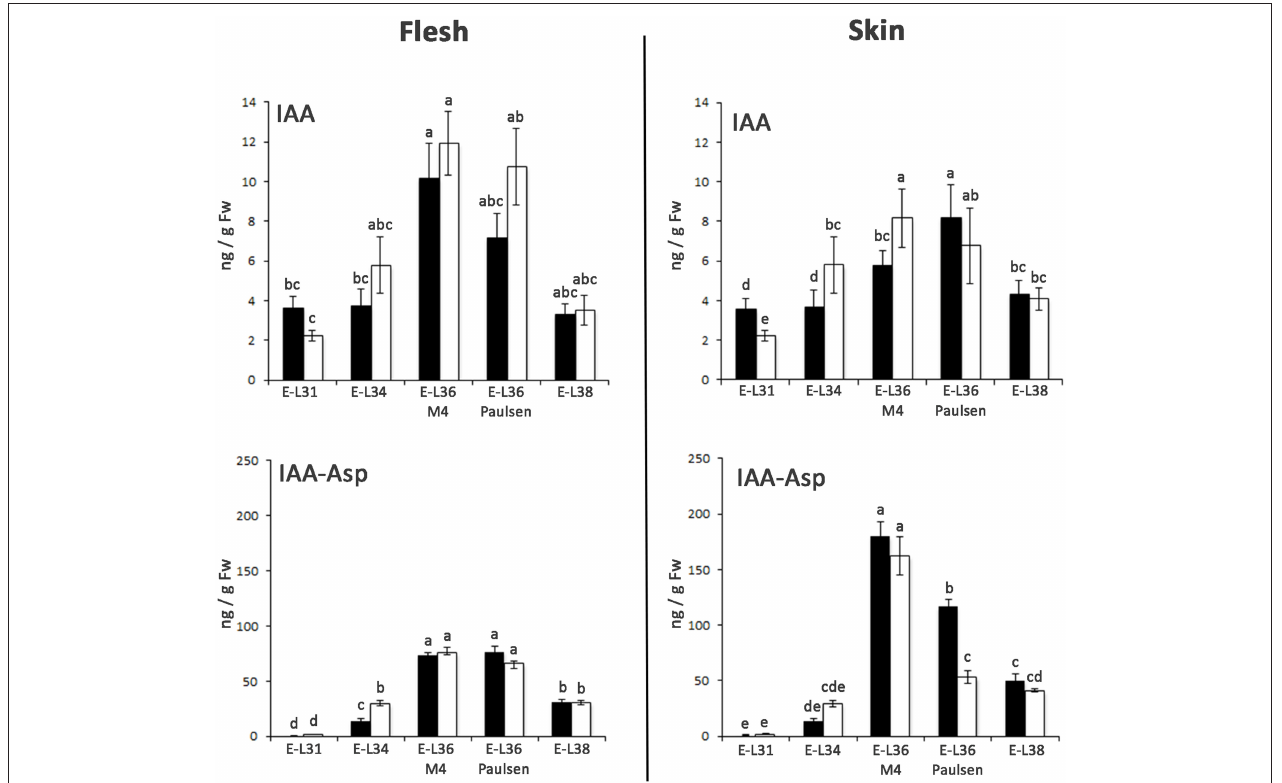
FIGURE 5 | Changes in levels of free IAA and IAA-Asp in flesh and skin of berries sampled from both 1103P/CS (solid bars) and M4/CS (empty bars) graft combination in 2011. IAA and the IAA-Asp were quantified by mean of LC-MS/MS at E-L31, E-L34, E-L36 M4, E-L36 Paulsen, and E-L38 developmental stages. Bars indicate SE of four replicates. Mean followed by the same letters are not statistically different at P = 0.05 (Duncan’s multiple-range